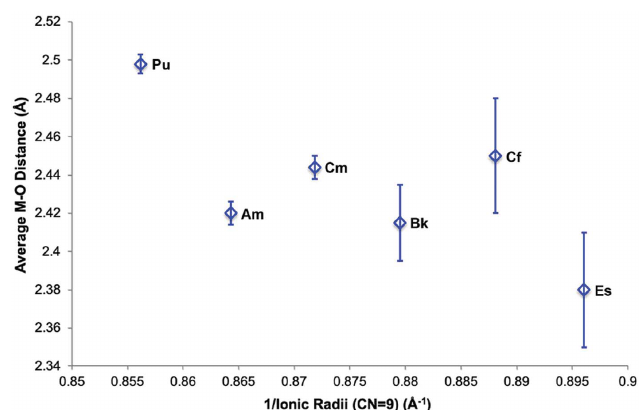
Figure 4 Comparison of An—O HOPO bond distances relative to the ionic radii of trivalent, transuranic actinides Pu–Es. Ionic radii were taken from Lundberg & Persson (2016), while Am, Bk, Cf, and Es data have been published previously (Kelley et al. , 2018; Carter, Shield et al. , 2021). Error bars are based on a profiling method from the fits, together with an estimate of the probable systematic error in the Cf and Es data (Carter, Shield et al. ,